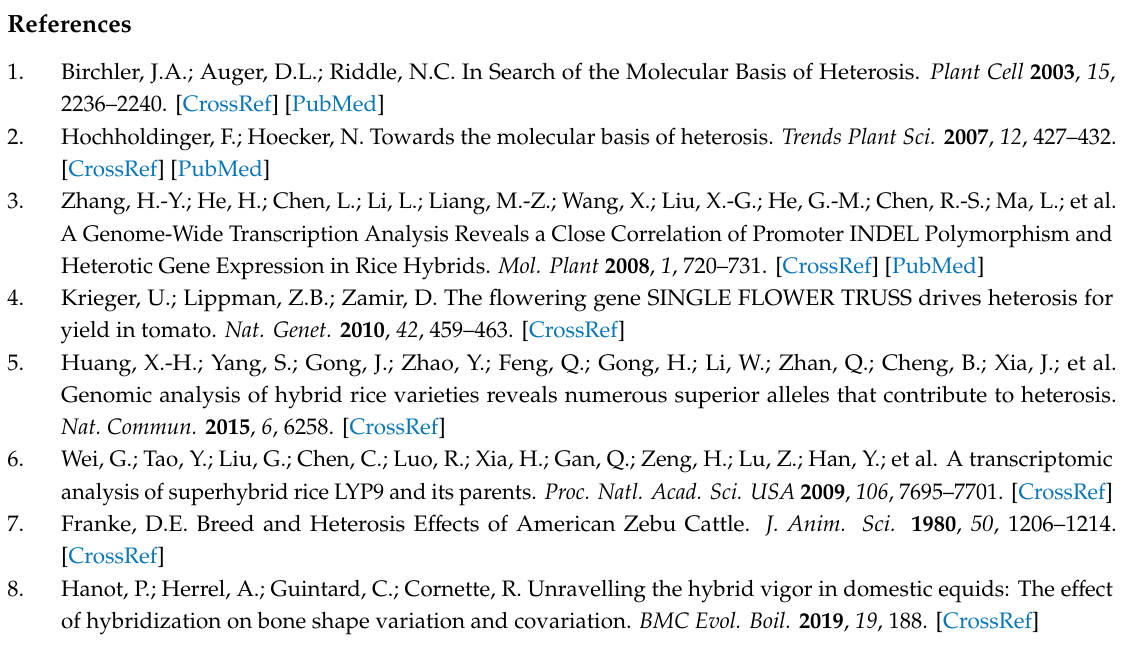
Table S1: Number of pathways enriched by the DEGs and DAS genes, Table S2: Table S2-1.xlsx Pathways enriched in muscle, brain and skin tissues by DEGs, Table S3: Table S3-1.xlsx Pathways in muscle, brain and skin tissues by DEGs and DAS genes that identified between mule and donkey, Figure S1: The PCA of the brain, muscle, and skin tissues in horses, donkeys, mules and hinnies, Figure S2: The venn diagrams of di ff erentially expressed genes among three tissues, Figure S3: Top 10 pathways enriched in muscle tissue by DEGs, Figure S4: Top 10 pathways enriched in brain tissue by DEGs, Figure S5: Top 10 pathways enriched in skin tissue by DEGs, Figure S6: The venn diagrams of di ff erentially expressed genes and di ff erentially spliced genes in brain, muscle, and skin tissues, Figure S7: Proportion of five splicing types of the DAS genes in three tissues, Figure S8: Top 10 pathways enriched in muscle tissue by DAS genes, Figure S9: Top 10 pathways enriched in brain tissue by DAS genes, Figure S10: Top 10 pathways enriched in skin tissue by DAS genes, Figure S11: Validation of DAS genes identified in the muscle tissues between mule and horse by the full-length transcriptome data generated from Pac-Bio sequencing platform, Figure S12 The result of transcriptome data mapping on the TNNC2 gene among the muscle tissues of hinny, mule, donkey and horse, Figure S13 The result of transcriptome data mapping on the RYR1 gene among the muscle tissues of hinny, mule, donkey and